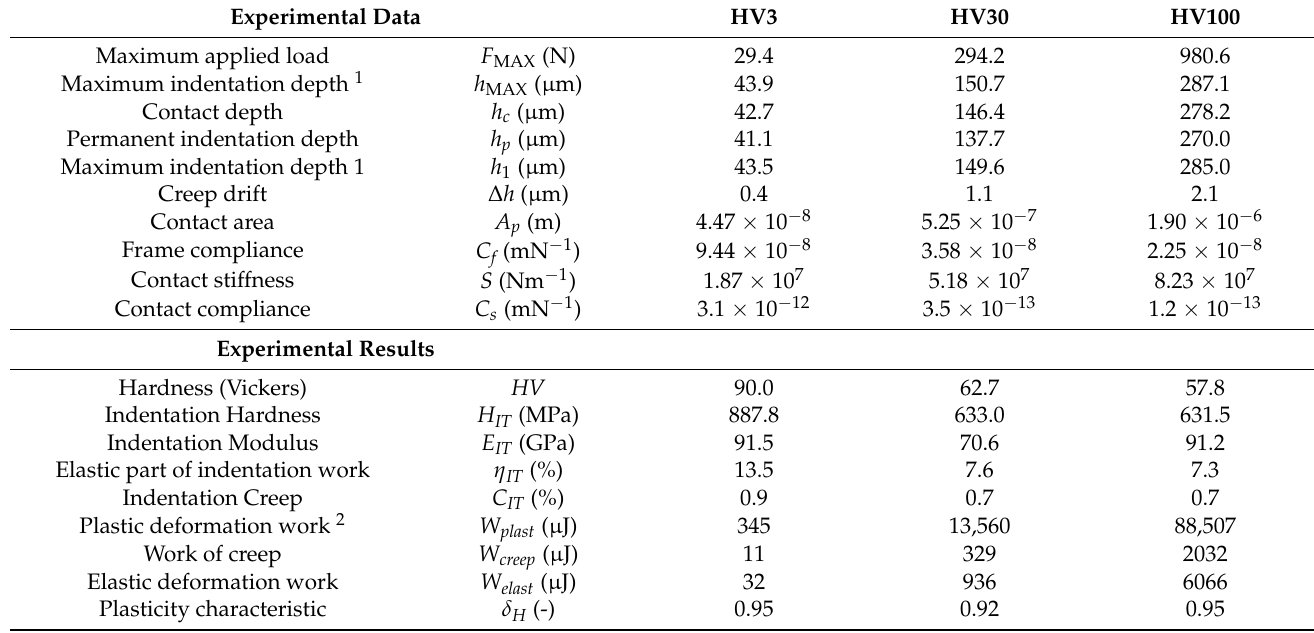
Table 5. Data of the HV test results on copper–chromium–zirconium